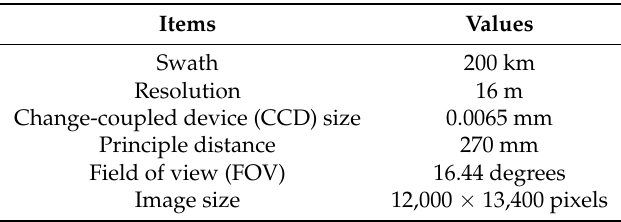
Table 2. Characteristics of the WFV camera onboard